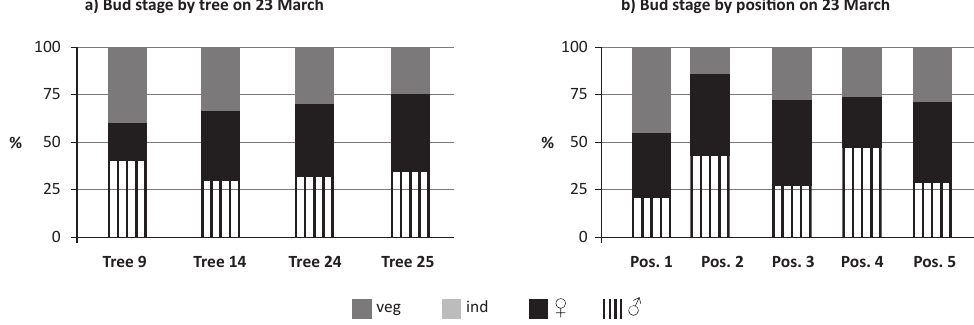
FiGure 5. Quantification of bud determination comparing tree and bud positions (pos.) on a branch (veg - vegetative, ind - undifferentiated, /veg - primordia of female inflorescences with vegetative buds, primordia of male inflorescences at 23 March